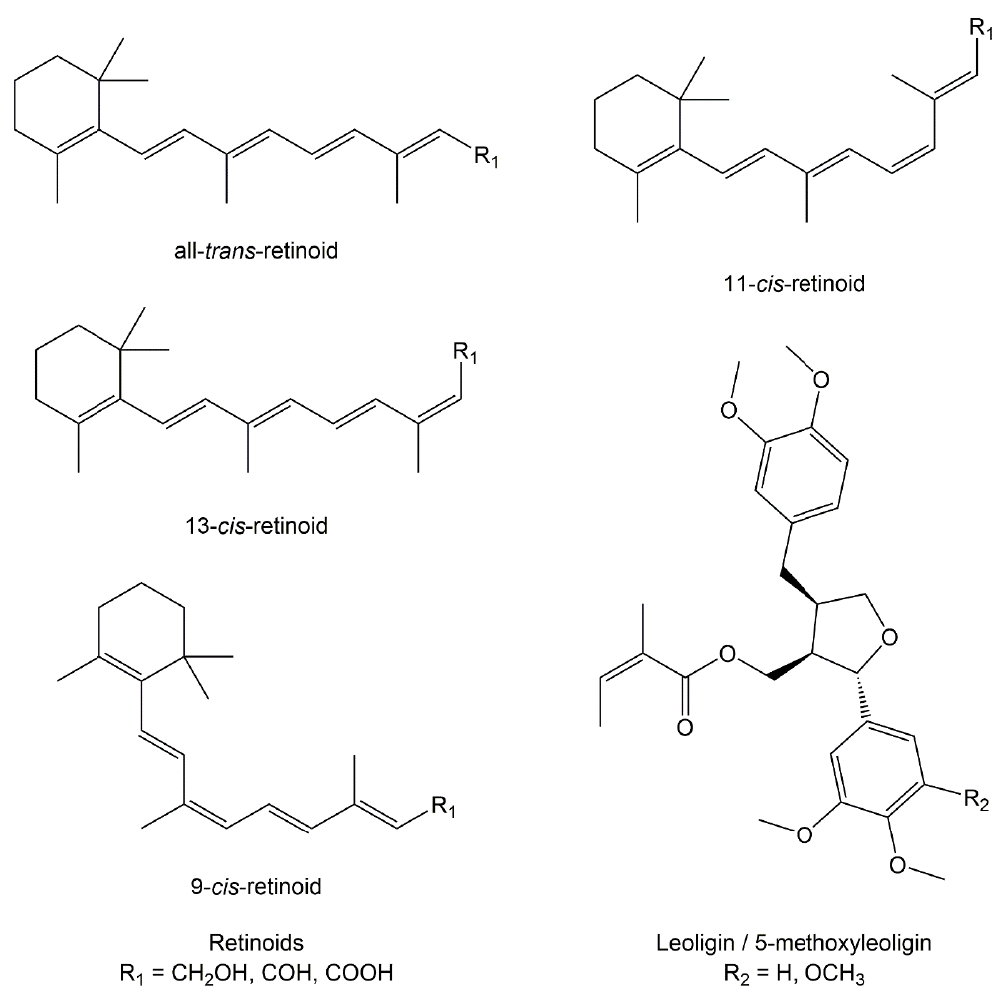
Figure 1. Overview of the substances under investigation.